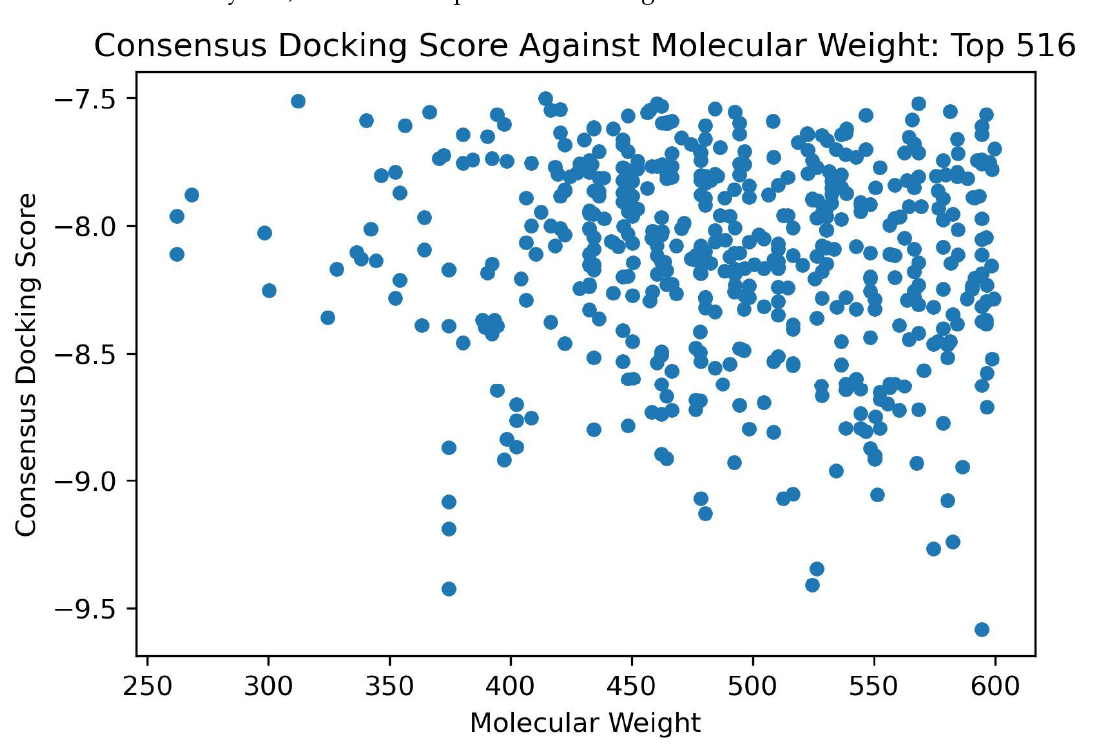
Figure 3. Consensus docking score against the molecular weight plot of the top 516 shortlisted compounds from molecular docking.